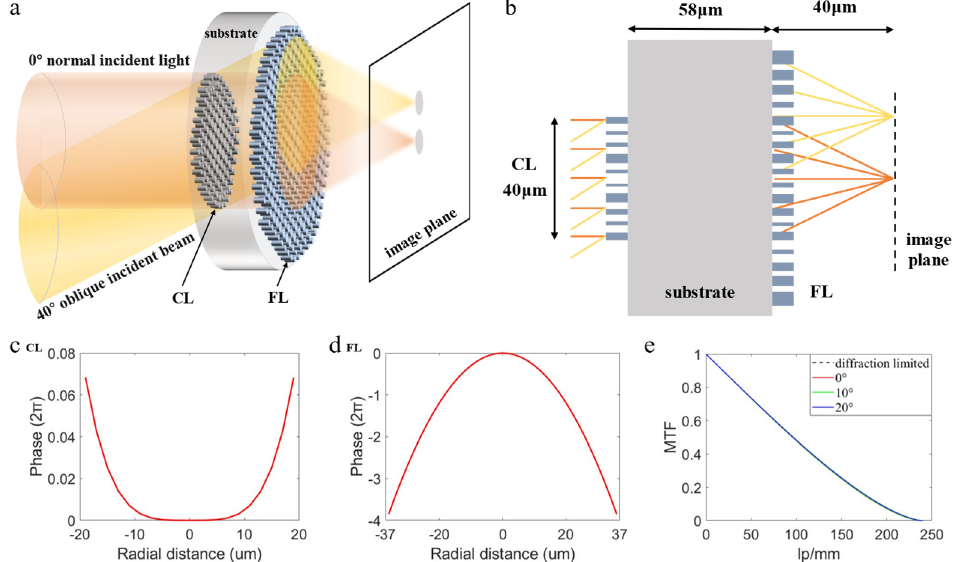
Figure 1. ( a ) Schematic diagram of the large FOV doublet metalens. ( b ) Schematic diagram of basic dimensions of the large FOV doublet metalens. ( c , d ) Ideal phase distribution of the CL and the FL. ( e ) MTF curves at each FOV and the diffraction limit.